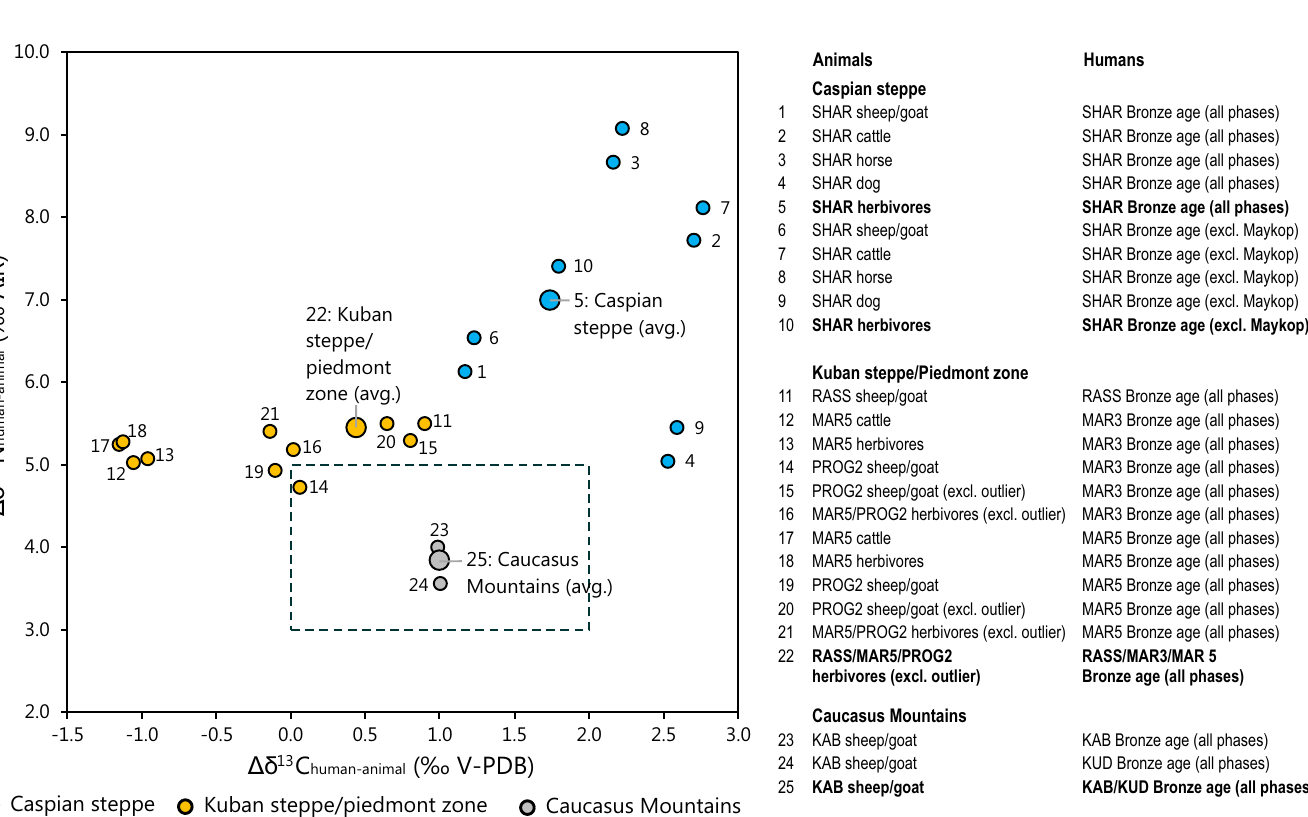
Fig 9. Differences between δ 13 C and δ 15 N values of bone collagen of humans and animals of different species from the Caucasus Mountains, Kuban steppe/ piedmont zone, and the Caspi steppe (cf. S2 Table). The box indicates the typical isotopic spacing between two adjacent trophic levels. Δδ 13 C human-animal and Δδ 15 N human-animal values within that range are in agreement with a human diet based on the respective animal sources. The numbers in the graph correspond to the numbers in the list of paired animal and human datasets to the right.